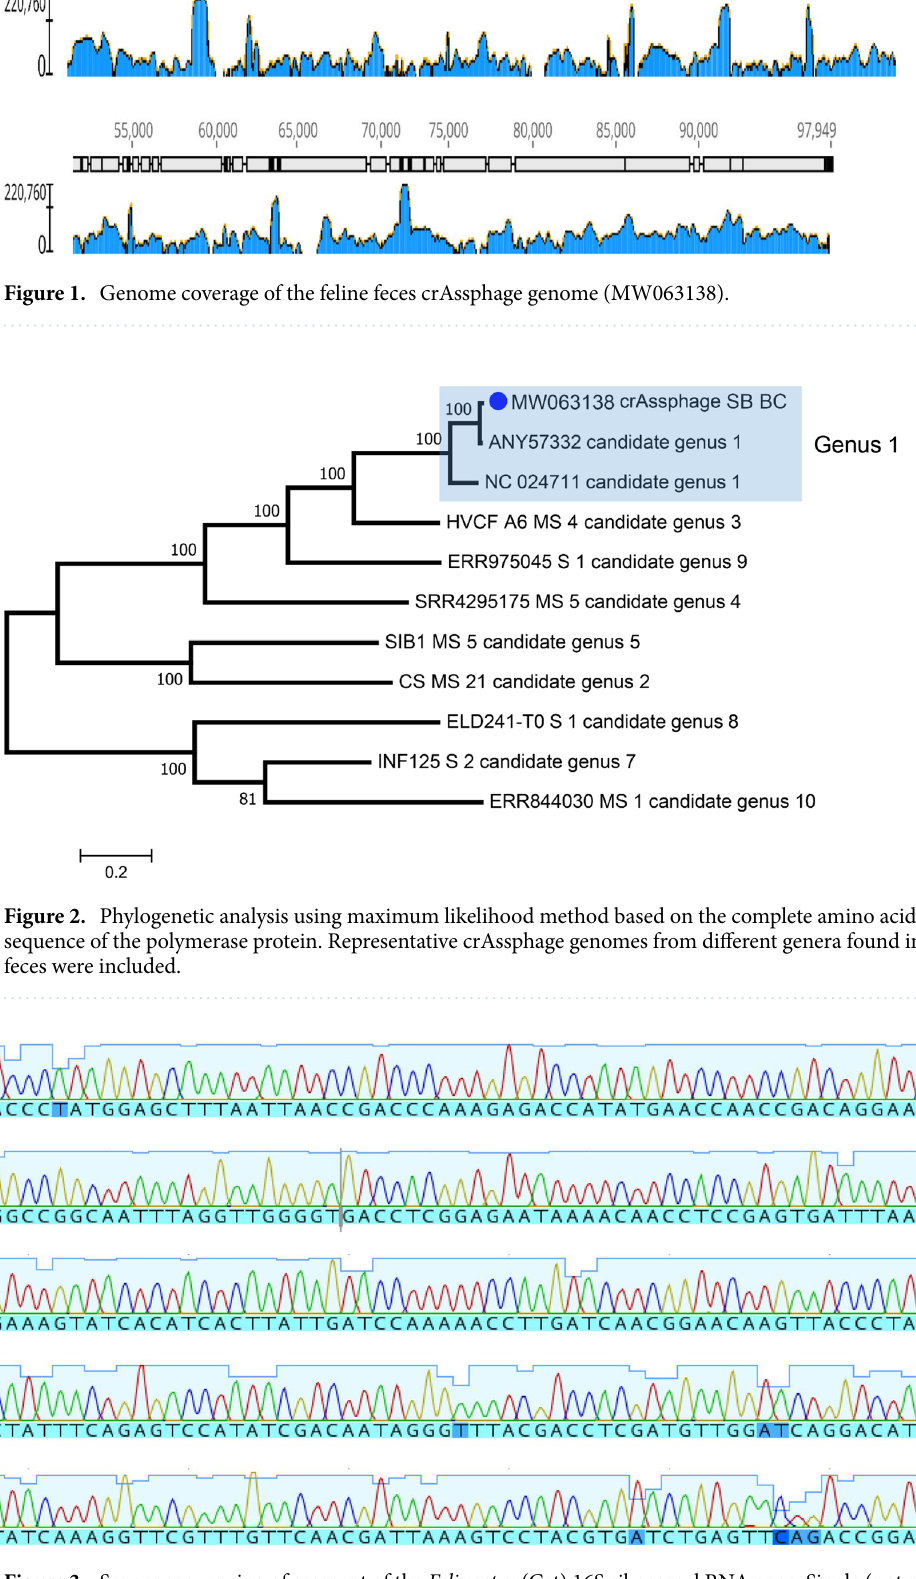
Figure 3. Sanger sequencing of segment of the Felis catus (Cat) 16S ribosomal RNA gene. Single (not mixed) electrophoregram peaks indicate absence of major contamination from other 16S rRNA